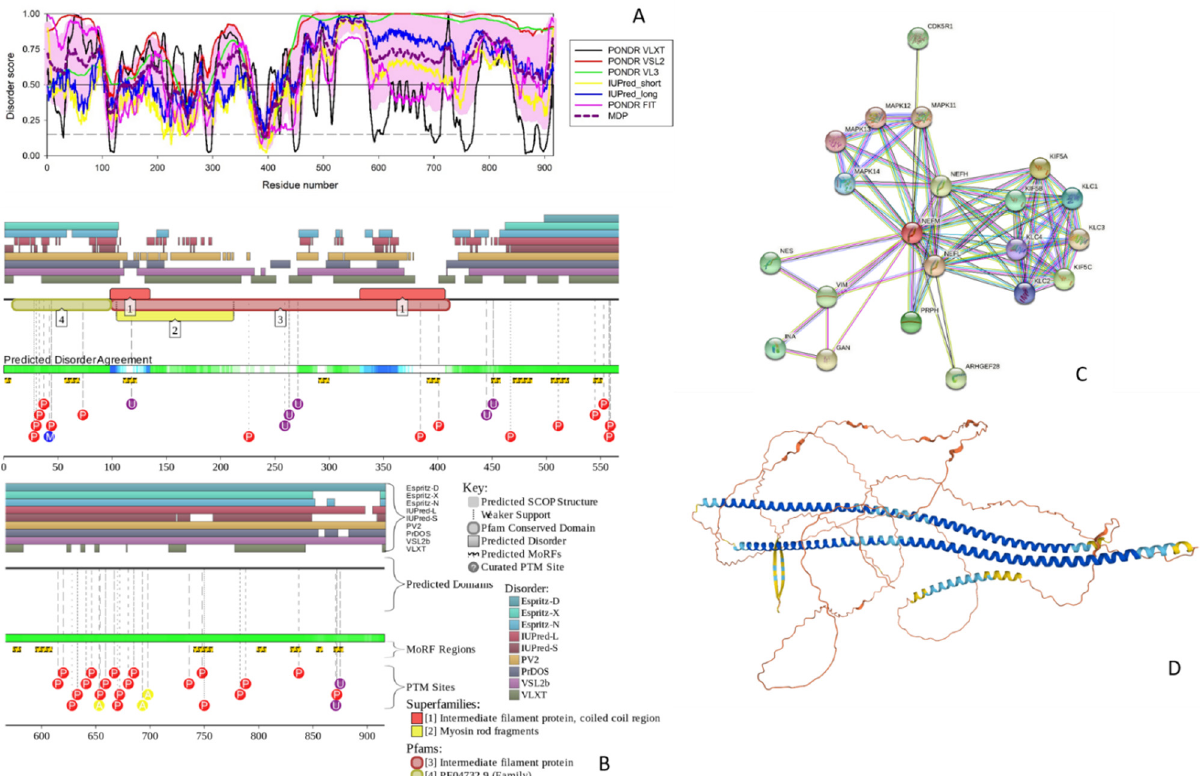
Figure 2. Functional disorder analysis of human NFM (UniProt IDs: P07197). ( A ) Per ‐ residue disor ‐ der profile generated by RIDAO. ( B ) Functional disorder profile produced by the D2P2 platform. ( C ) STRING ‐ generated PPI network centered at NFM. ( D ) 3D structure modeled for NFM by Al ‐ phaFold. Structure is colored based on the pLDDT values, where segments predicted with very high (pLDDT > 90), high (90 > pLDDT > 70), low (70 > pLDDT > 50), and very low (pLDDT < 50) confi ‐ dence are shown by blue, cyan, yellow and orange colors, respectively.